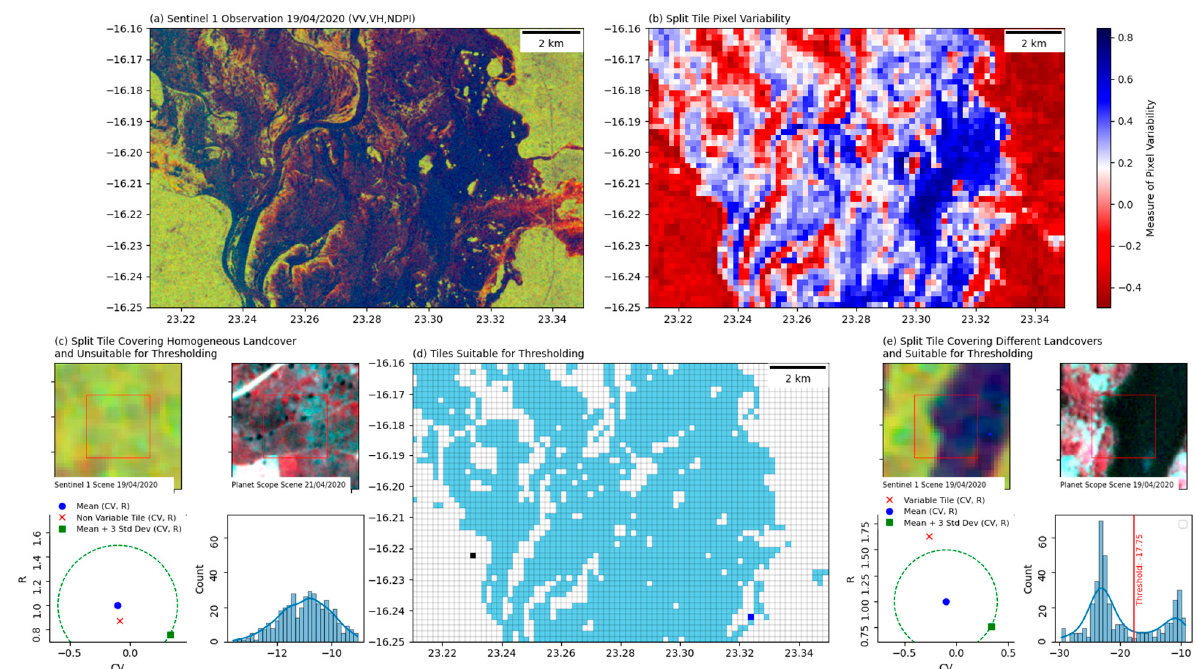
Figure 4. Diagram-based description of the split-based thresholding routine showing: ( a ) Input Sentinel-1 observation, ( b ) split tile variability based on sub-tile cv and r Euclidean distance to 𝑐𝑣(cid:3364)(cid:3364)(cid:3364) and 𝑟̅ , ( c ) visual description of a homogenous sub-tile showing cv and r with the boundary of 3 Standard Deviations from 𝑐𝑣(cid:3364)(cid:3364)(cid:3364) and 𝑟̅ , and histogram of VV backscatter values, ( d ) candidate heterogenous sub-tiles used for threshold calculation, ( e ) candidate heterogenous sub-tile covering a class boundary of open water and dry background land cover, a histogram of VV backscatter values are included as well as subsequent split-based threshold.